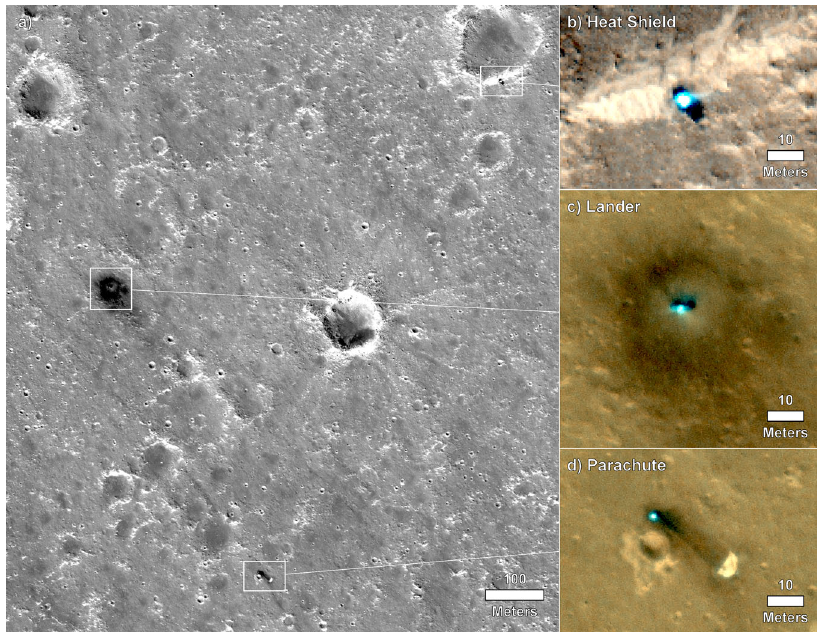
Fig. 3 HiRISE image of InSight. a Image acquired on December 6, 2018 showing a regional view of the location of the InSight lander, parachute and backshell, and heatshield. Also shown are close ups of the heat shield ( b ) lander ( c ) and parachute and backshell ( d ) in color. Note the 20 m radius dark spot around the lander, with the slightly brighter interior. The gradational extension of the dark spot to the southeast is along the prevailing wind direction from the northwest estimated from orbit 3 and measured by InSight early in the mission 41 . Note smaller dark spots associated with the backshell and heatshield, and the relatively fresh Sunrise crater 400 m to the east of the lander. Note circular impact craters in a wide variety of degradational